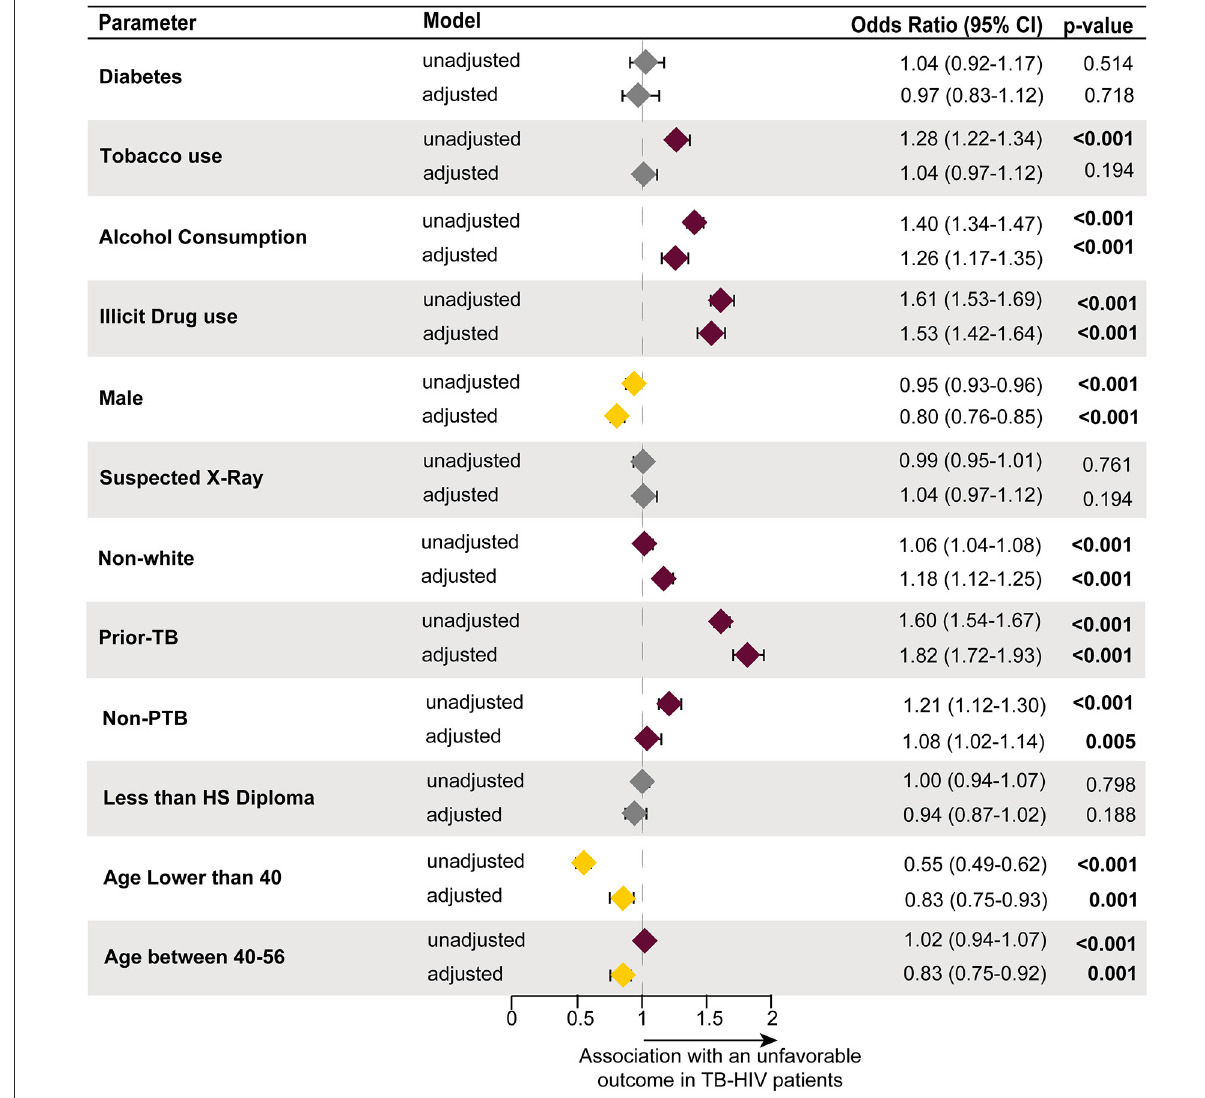
FIGURE2 An enter method binomial logistic regression model was used to test which factors had an association with treatment outcome in the TB-HIV population. The reference utilized to test associations was a favorable treatment outcome. The following variables were statistically associated with an unfavorable treatment outcome, alcohol consumption (reference: no for alcohol consumption), illicit drug use (reference: no for illicit drug use), non-white (reference: white ethnicity), prior TB (reference: new TB diagnosis cases), and non-PTB (reference: PTB). While age lower than 40 (reference: age higher than 56), age between 40 and 56 (reference: age higher than 56) and male (reference: female sex) increased the likelihood of progressing into a favorable outcome. Diabetes (reference: non-diabetes), tobacco use (reference: no for tobacco use), suspected X-ray (reference: normal x-ray), and less than HS diploma (reference: more than HS diploma) were all not statistically significant. TB, tuberculosis; HIV, human immunodeficiency virus; PTB, pulmonary tuberculosis; HS, high school; Non-PTB, extrapulmonary